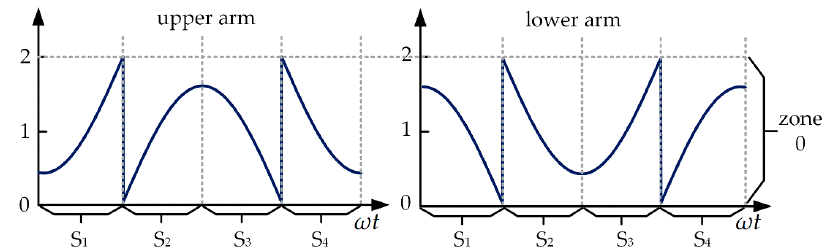
Figure 8. The integrated modulation signals.